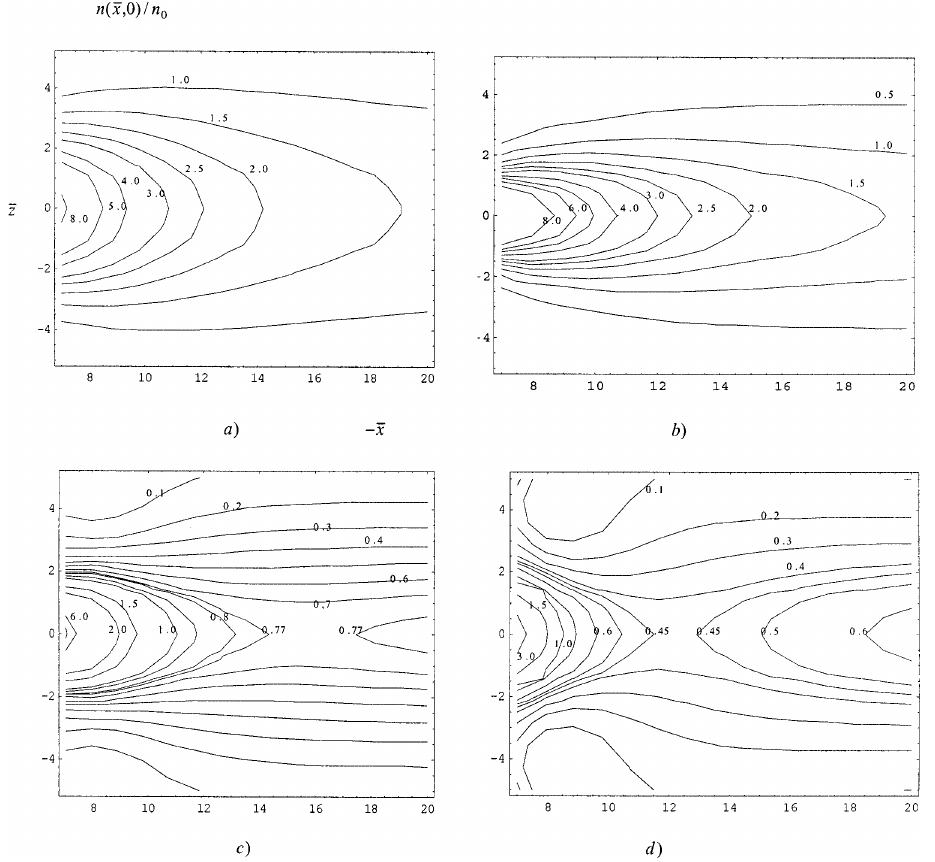
Fig. 4. Isolines of the plasma density (current density): n(x,z)/n 0 = j(x,z)/j 0 . Number of the curves corresponds to the value of the dimensionless plasma density (current density). The value x b , B ∞ , γ , m as in Fig.